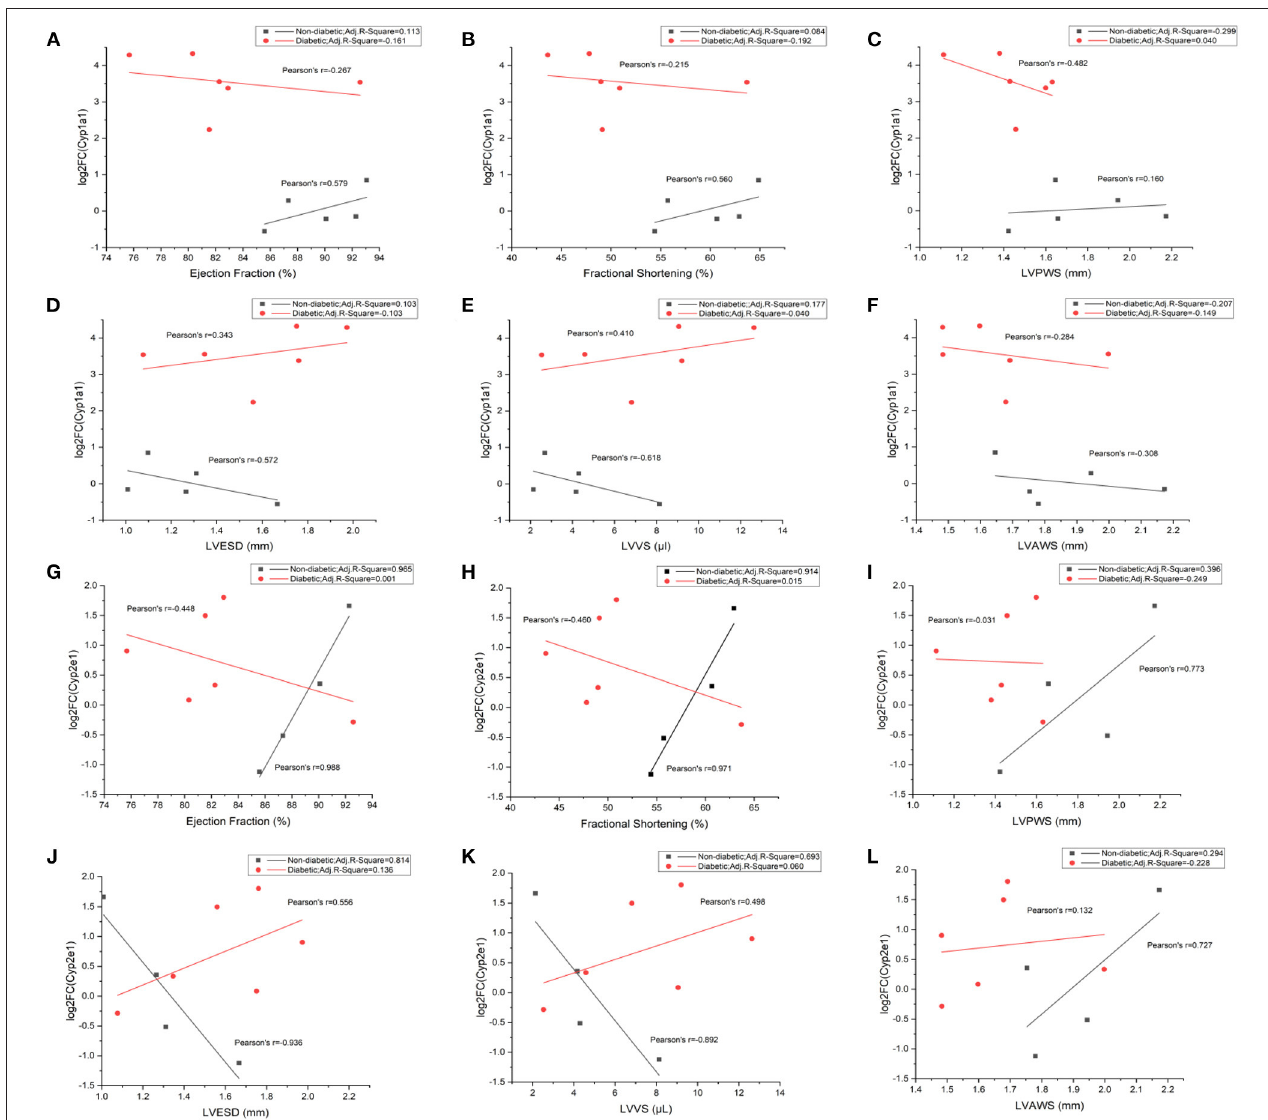
FIGURE 8 | Correlations between Cyp1a1 / Cyp2e1 mRNA levels and cardiac functional parameters in non-diabetic and STZ-induced diabetic mice. (A) Correlations between log2-fold change (log2FC) of Cyp1a1 and ejection fraction; (B) Correlations between log2FC of Cyp1a1 and fractional shortening; (C) Correlations between log2FC of Cyp1a1 and LVPWS; (D) Correlations between log2FC of Cyp1a1 and LVESD; (E) Correlations between log2FC of Cyp1a1 and LVVS; (F) Correlations between log2FC of Cyp1a1 and LVAWS; (G) Correlations between log2-fold change (log2FC) of Cyp2e1 and ejection fraction; (H) Correlations between log2FC of Cyp2e1 and fractional shortening; (I) Correlations between log2FC of Cyp2e1 and LVPWS; (J) Correlations between log2FC of Cyp2e1 and LVESD; (K) Correlations between log2FC of Cyp2e1 and LVVS; (L) Correlations between log2FC of Cyp2e1 and LVAWS. n = 4–6 mice per group.